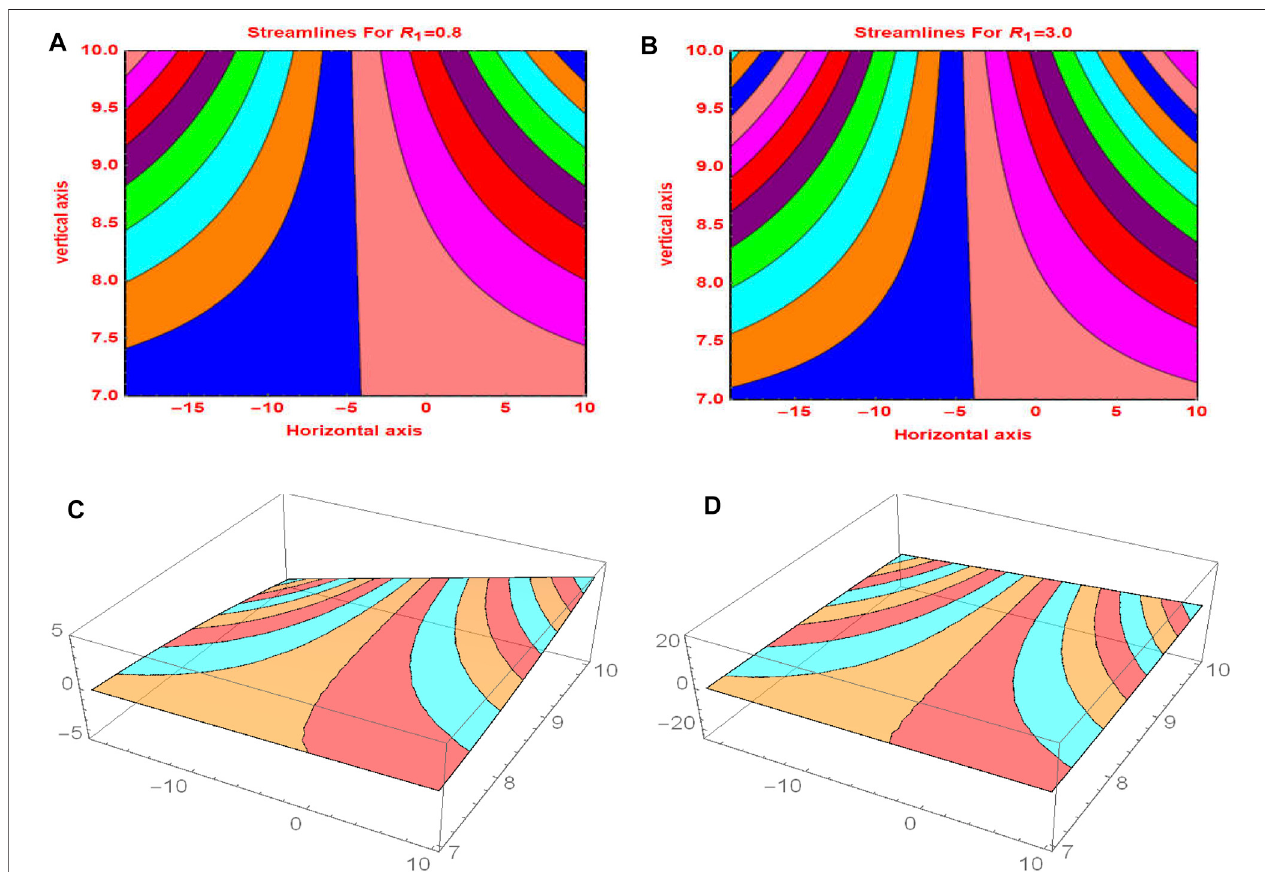
FIGURE 16 | Streamlines via (A) R 1 (cid:2) 0 . 8, (B) R 1 (cid:2) 3 . 0, (C) 3D for R 1 (cid:2) 0 . 8, and (D) 3D for R 1 (cid:2) 3 .